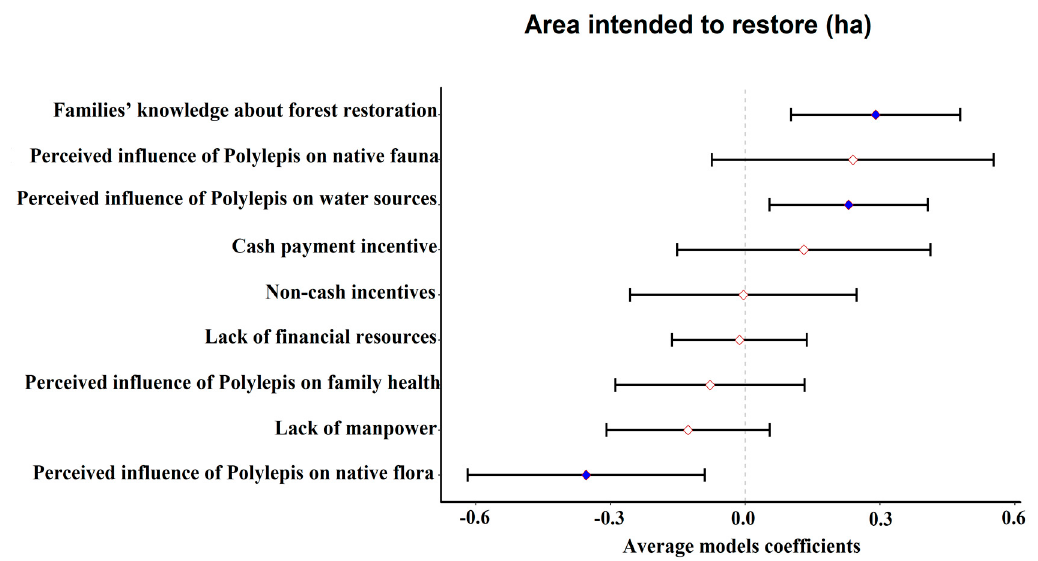
Figure 5. Average models coefficients analyzing the influence of the family perception variables in the size of the Polylepis forest areas that they intend to restore in the properties.